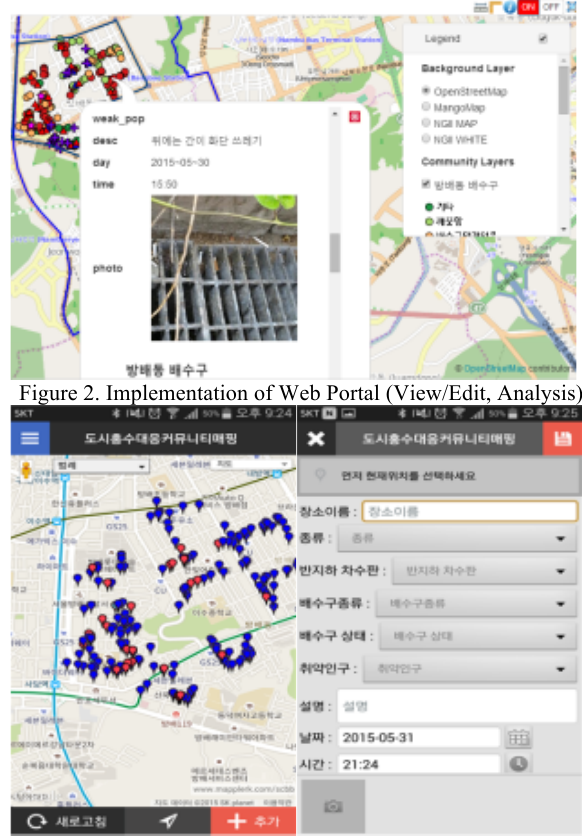
Figure 2. Implementation of Web Portal (View/Edit, Analysis)